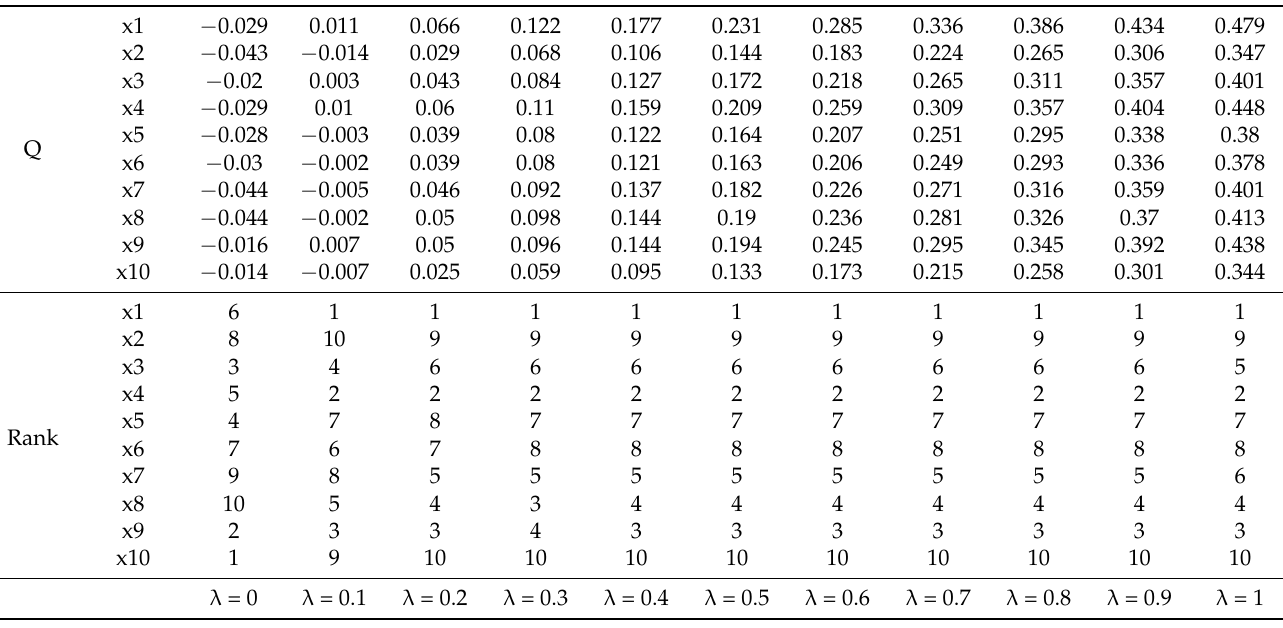
Table 16. Results of SF- WASPAS in term of Scores and Rankings.